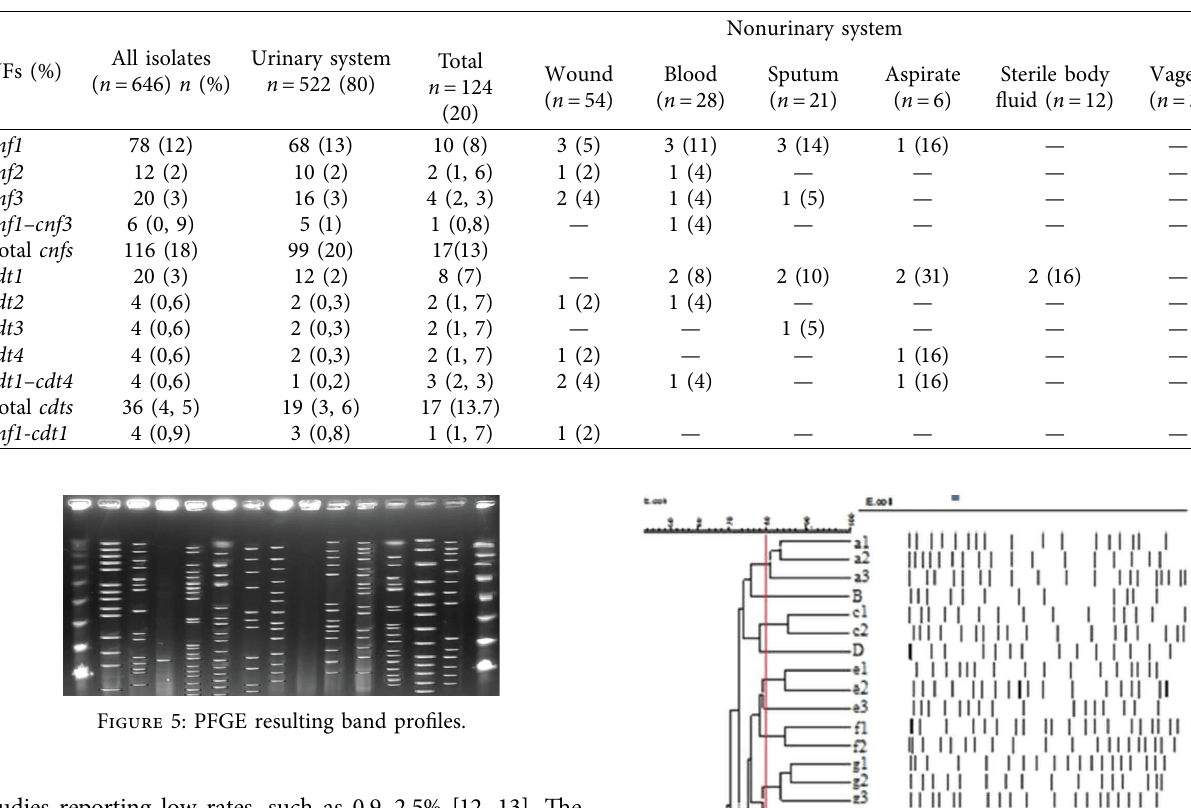
Table 3: Te distribution of toxin genes in 646 ExPEC isolates.